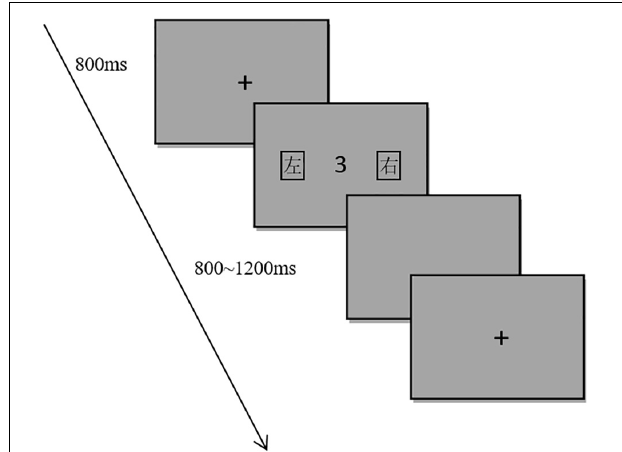
FIGURE 6 | Flow chart of Experimental 2.